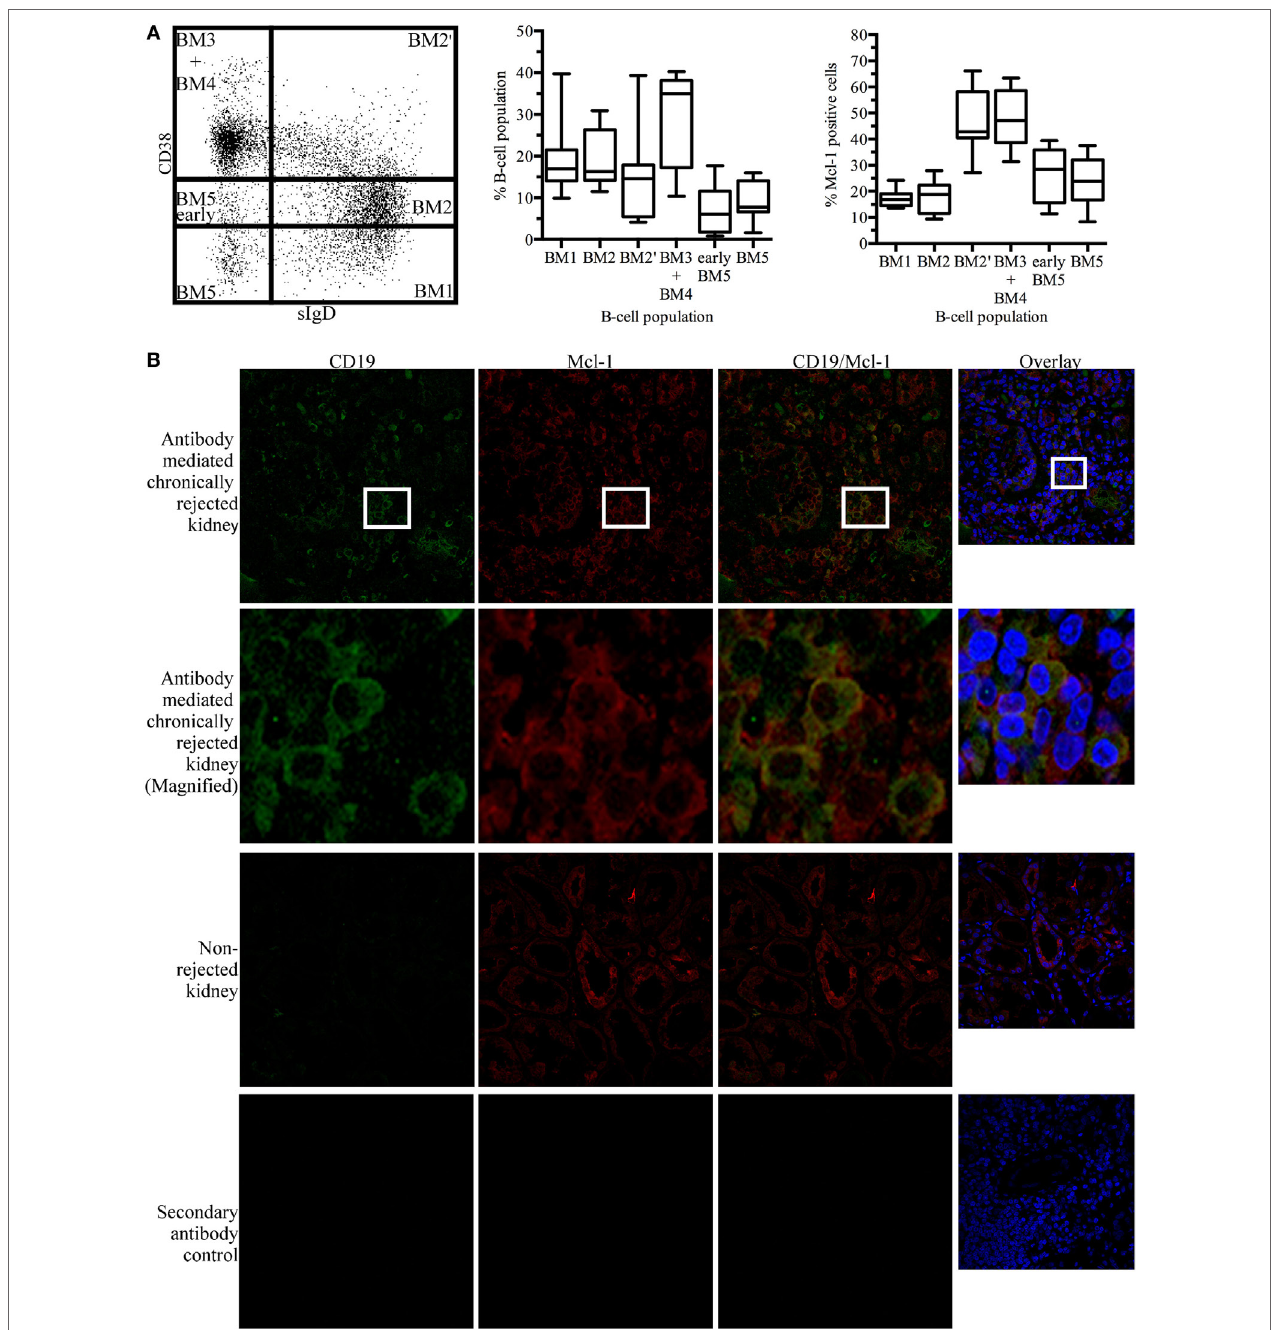
FigUre 1 | Myeloid cell leukemia-1 (Mcl-1)-expressing B cells are found in kidney grafts in cases of chronic antibody-mediated rejection (a) Unstimulated tonsillar cells were stained for CD19, sIgD, CD38, and Mcl-1 and analyzed by flow cytometry. B-cell populations were identified according to the BM1-BM5 classification, based on the expression of CD19, sIgD, and CD38, and additional staining for Mcl-1 was performed. The boxplot shows the distribution between donors and the quadrant indicates the values between the fifth and ninety-fifth percentiles, n = 7. (B) Immunofluorescence staining of paraffin-embedded chronically rejected kidney with anti-CD19 and anti-Mcl-1 antibodies. Images were obtained with a Leica confocal microscope fitted with a 63 × objective. sIgD, surface IgD; CD, cluster of differentiation; BM, mature B